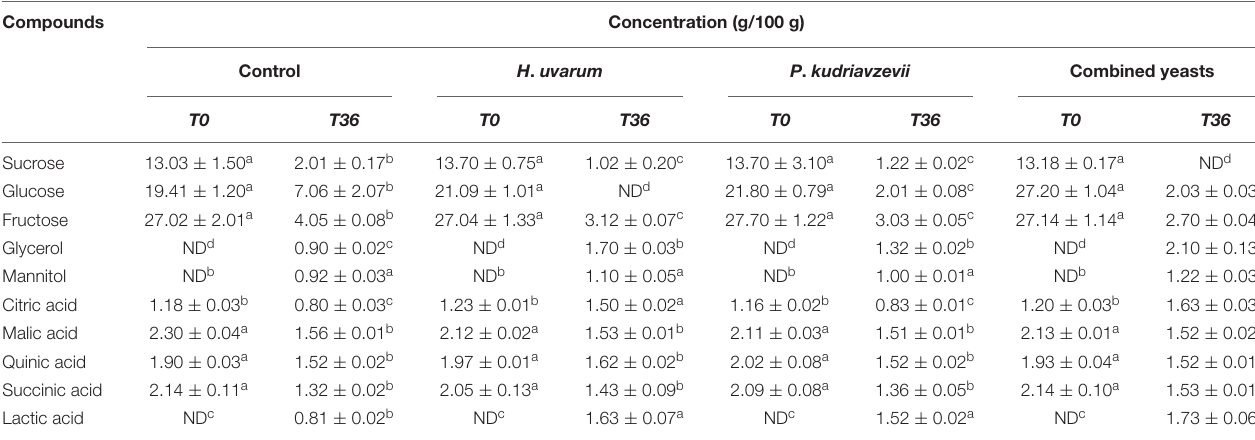
Lactic acid Means in each row bearing the same letters are not significantly different (p > 0.05) from one another using Tukey’s test (mean ± standard deviation).